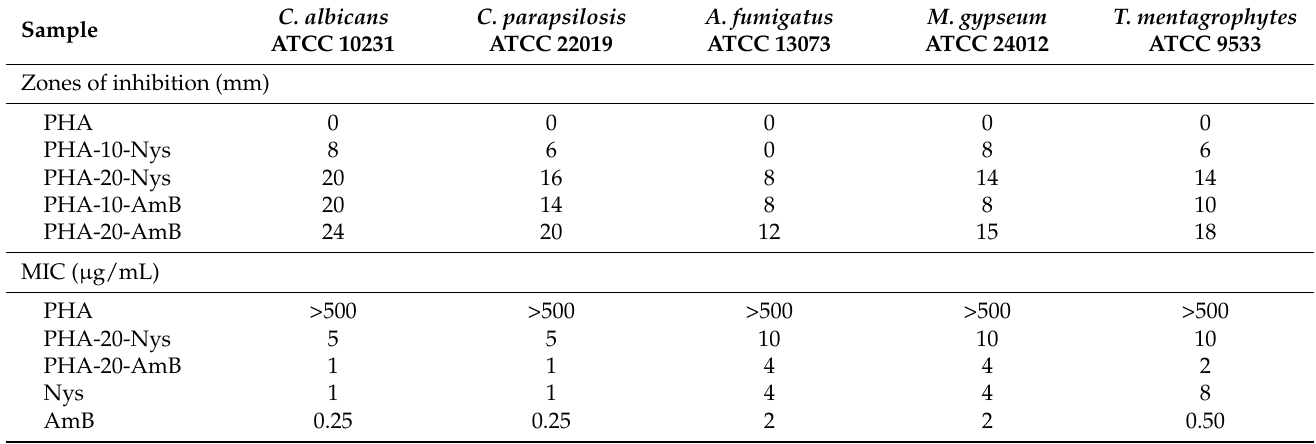
Table 1. Antifungal activity of different PHA/polyene formulations against C. albicans , C. parapsilosis , A. fumigatus , M. gypseum and T. mentagrophytes , expressed as the diameter of inhibition zones (mm) and MIC values ( µ